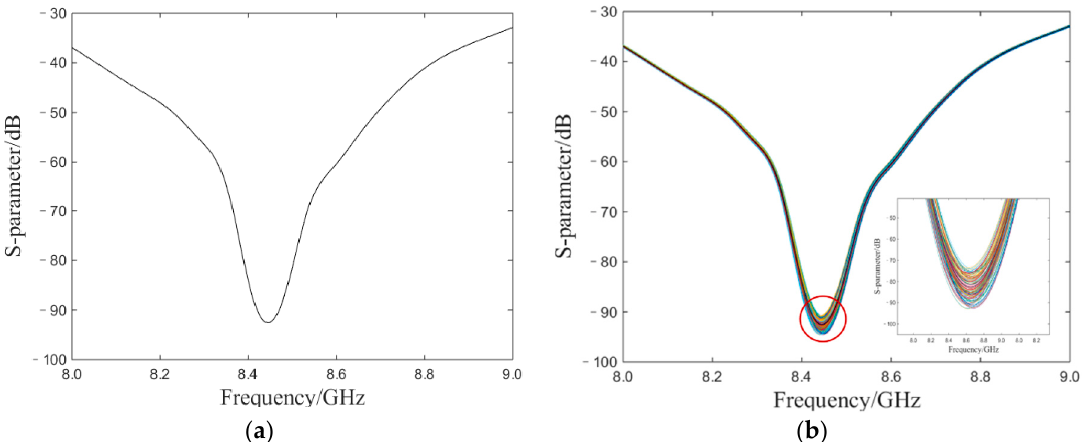
Figure 3. ( a ) The simulated S-parameters spectrum of signal frequency domain. ( b ) The simulated S-parameters of simulations with noise.